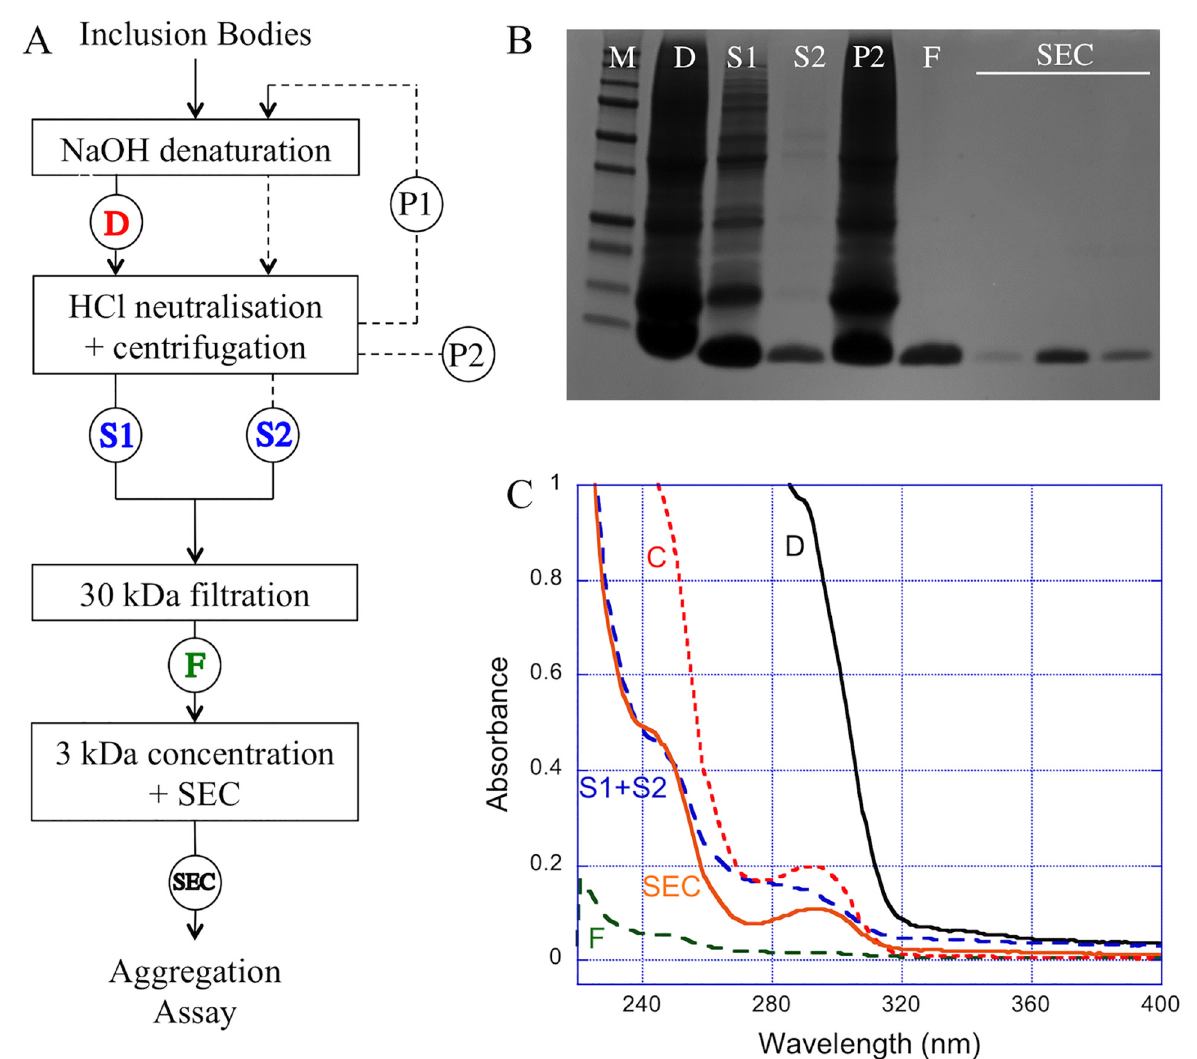
Fig 2. Purification monitoring of MA β . A. Simplified scheme of the purification procedure. Circled letters correspond to samples collected for either UV/Vis measurements or gel analysis. Supernatant S1 and S2, and pellet P1 and P2 correspond to the supernatant and the precipitate obtained for the two cycles of denaturation/neutralisation. B. SDS-PAGE at different steps of purification, compared with 10 – 250 kDa protein marker (lane M). C. UV-Vis spectra at pH 12 after IBs denaturation (D), after denaturation/neutralisation cycles (S1+S2), after 30-kDa ultrafiltration (F), after concentration (C), and after size exclusion chromatography (SEC).